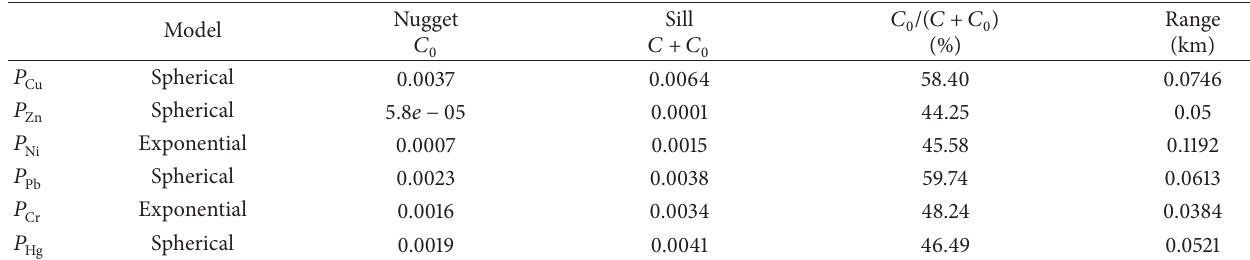
Table 4: Spatial correlation for heavy